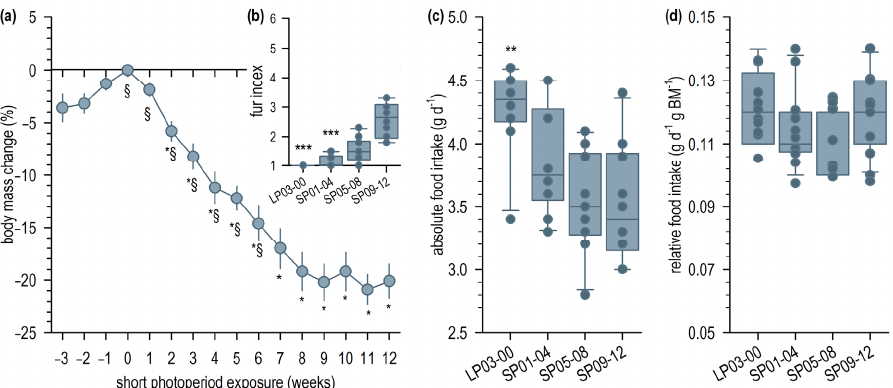
Figure 1. Indicators of short photoperiod (SP) acclimation. ( a ) Mean relative body mass change (± SEM) of the investigated hamster group ( n = 10) during twelve weeks of SP exposure; One Way Repeated Measures ANOVA, F (12, 108) = 53.6, p < 0.001; Bonferroni post hoc test with a significant difference from week 0 (*), the beginning of the SP exposure, or a significant difference from week 12 (§), shortly before sacrifice; p ≤ 0.05. ( b ) Median fur index (25th, 75th quartile) in four acclimation intervals, whereby LP03-00 refers to long photoperiod; Friedman ANOVA, χ 2 (3) = 27.6, p < 0.001; Tukey post hoc test with *** marking a significant difference from LP09-12. ( c ) Median daily food intake during the four acclimation intervals; One Way Repeated Measures ANOVA, F (3, 24) = 18.2, p < 0.001; Bonferroni post hoc test with ** marking a significant difference from all other intervals. ( d ) Median daily food intake in relation to individual body mass.